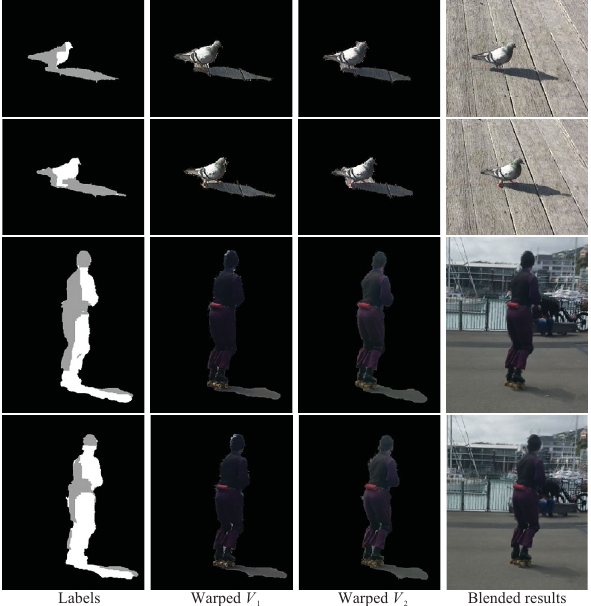
Fig. 7 A 3D spatiotemporal graph cut optimization is used to find the best seam at which we can transition between the foreground contents from the two different videos. Here the grey label indicates that the pixel should use the color from the warped video V 1 , and white indicates V 2